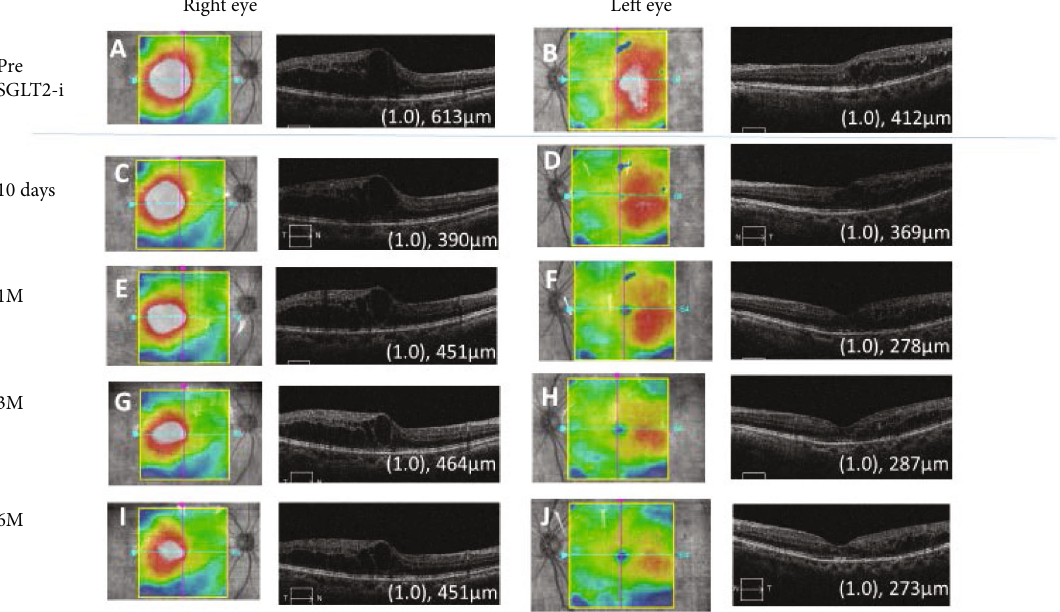
Figure 3: Case 3. Optical coherence tomographic images and fundus photographs showing the central macular thickness (CRT) pre (A, B) and at 10 days (C, D), 1 month (M) (E, F), 3 M (G, H), and 6 M (I, J) after commencing the oral sodium-glucose cotransporter 2 inhibitor